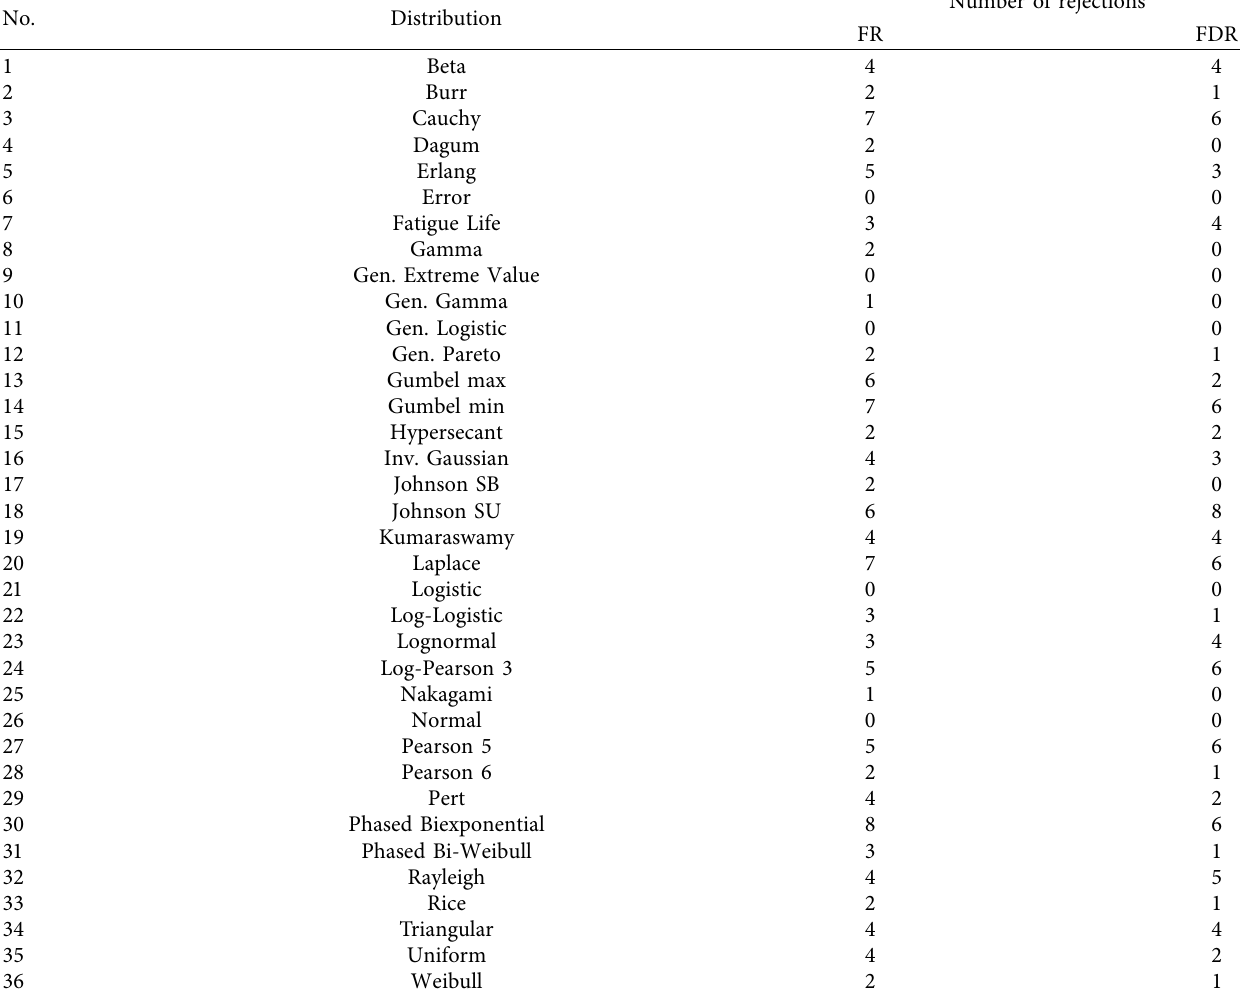
Table 4: Candidate distributions fitting results for bus failure